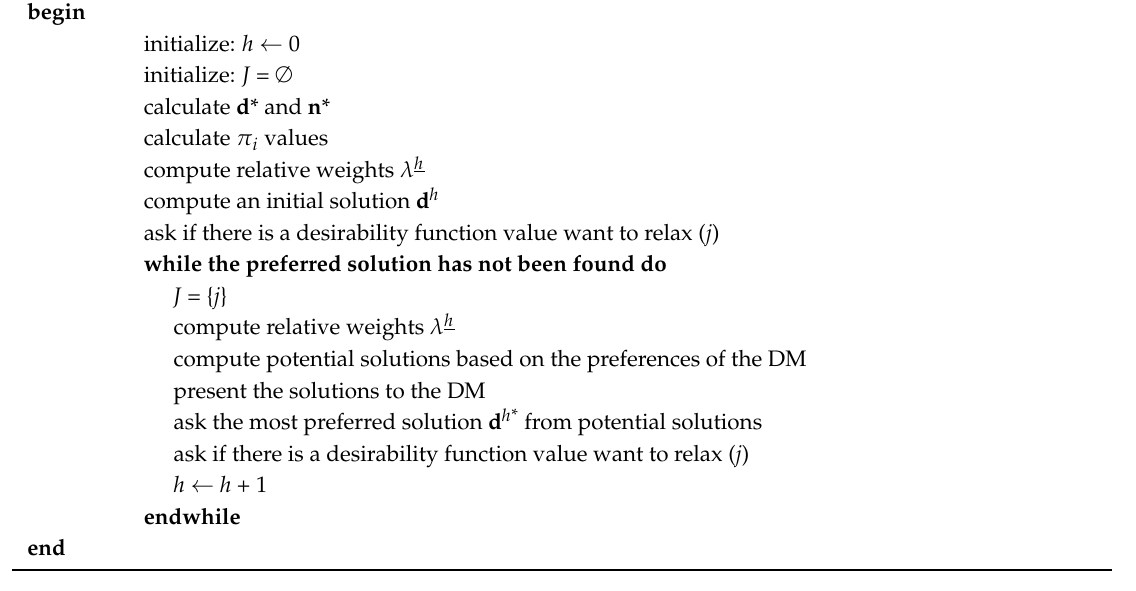
Algorithm 1. Pseudo code of the proposed method.